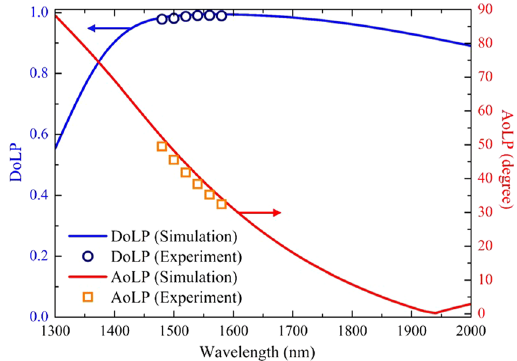
Figure 6. DoLP and AoLP extracted from experimental measurements and simulations for circularly polarized excitation at normal